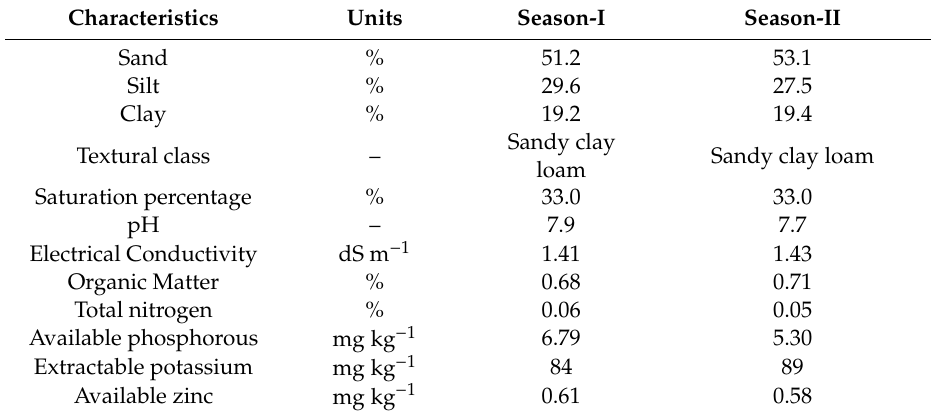
Table 1. Soil physicochemical characteristics of a field experiment in two di ff erent cropping